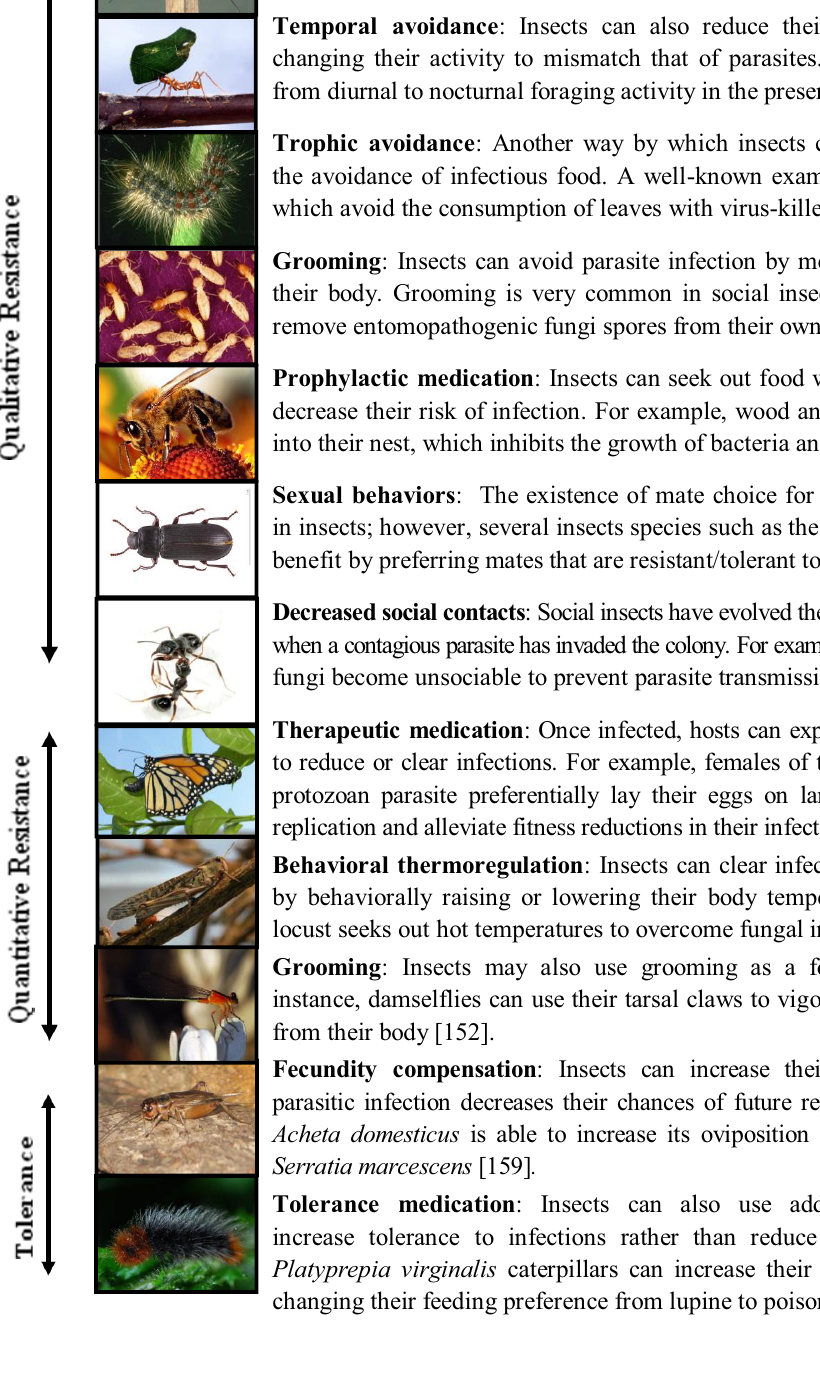
Figure 1. Examples of host behaviors that confer qualitative resistance, quantitative resistance and tolerance. All pictures downloaded from wikipedia except photos illustrating spatial avoidance, decreased social contacts, therapeutic medication and tolerance medication respectively by Hiroyuki Hirayama, Volker Nehring, Jacobus C. de Roode and Virgiliu Marius Aurelian